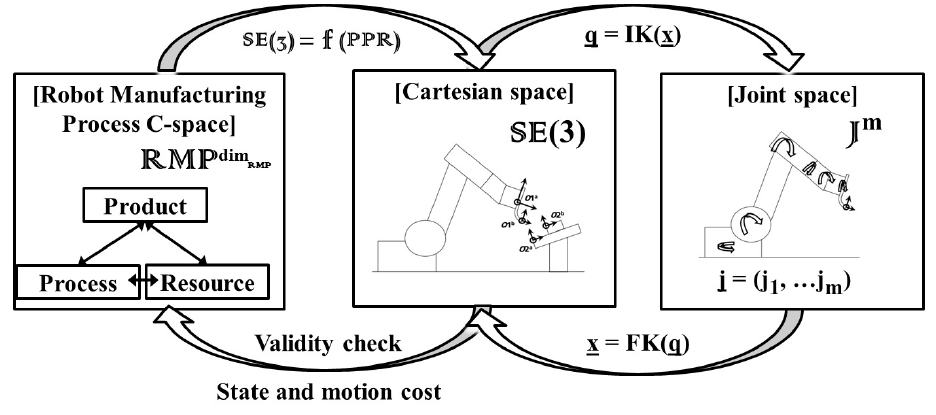
Figure 2. Spaces for the optimal motion generation in robotic